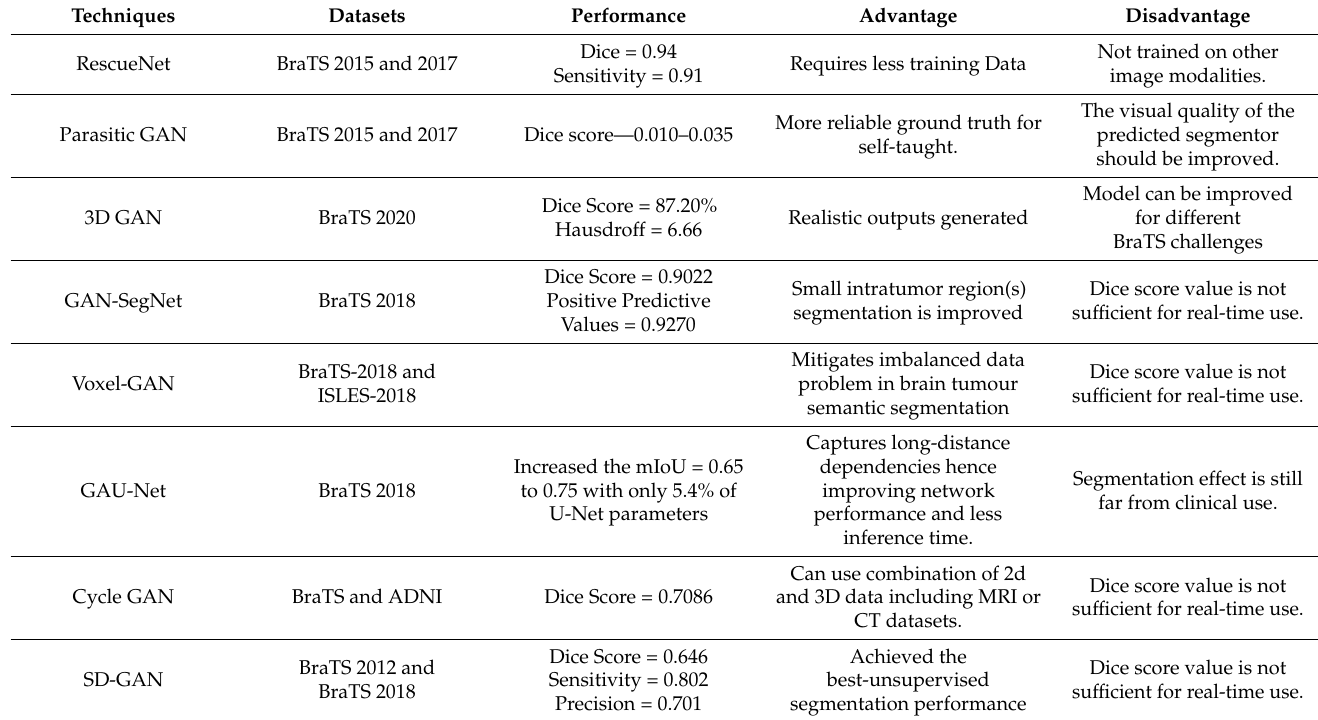
Table 2. Literature Survey of GAN-based Brain tumour Segmentation